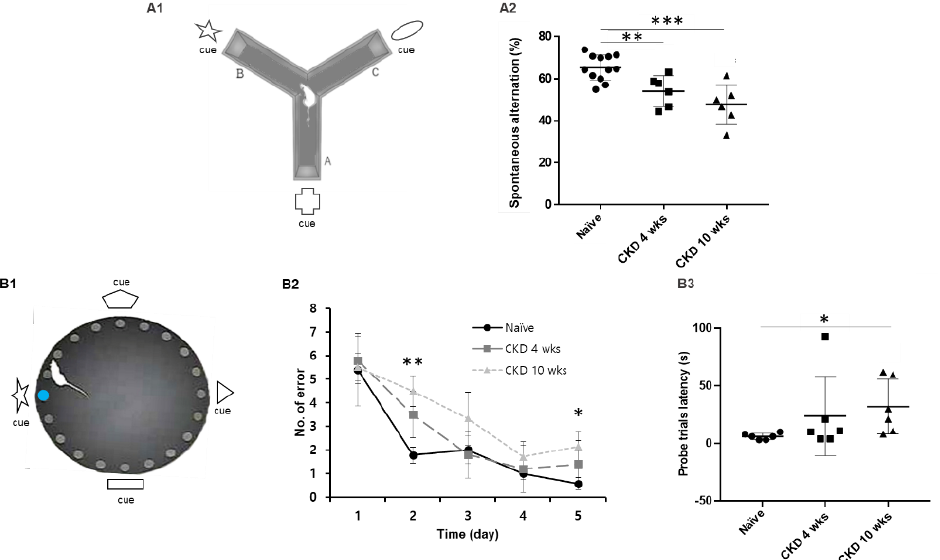
Figure 2. Decreased spatial working memory in CKD model rats. A schematic diagram showing the special cues working memory test ( A1 ). In the CKD rats, the average percentage of spontaneous movement was decreased compared with naïve rats ( A2 ). Barnes maze apparatus was used to ex- amine spatial learning and memory in CKD model rats ( B1 ). The number of errors for escape hole was reduced for all rats upon repeated trials ( B2 ). CKD 10-wk rats had a higher time of error on the second day and fifth day (probe test) compared with naïve rats ( B2 ). The latent time to find the target hole increased on the probe test day in the CKD 10 wks compared with naïve rats. ( B3 ). The blue round symbol in B1indicates the escape hole. Data are presented as means ± SEM. * p < 0.05, ** p < 0.01, *** p < 0.001 by one-way analysis of variance. Y-maze, naïve: n = 12; CKD 4 wks: n = 7; CKD 10 wks: n = 5; Barnes maze: n = 6/group. Additionally, we investigated whether CKD could cause learning and memory dis- orders in contextual fear conditioning (Figure 3). In freezing contextual fear learning, CKD 10-wk rats showed decreased freezing times (6 min, F 1,10 = 6.04, p < 0.05, 7 min, F 1,10 = 7.59, p < 0.05; one-way ANOVA; Figure 3A). After 24 h, contextual fear memory deficits were observed in the CKD rats compared with the naïve rats (CKD 4 wks, F 1,10 = 10.87, p < 0.05, CKD 10 wks, F 1,10 = 18.51, p < 0.001; one-way ANOVA; Figure 3B), indicating that CKD led to deficits in hippocampus-dependent memory. Figure 3. Impairment of contextual fear memory in CKD 4, 10- wk rats. Contextual and cued fear conditioning and 24-h retrieval of contextual memory were performed ( A , B ) No differences in clas- sical fear conditioning were observed in CKD 4-wk rats, although CKD 10-wk rats spent a signifi- cantly lower percentage of time freezing compared with naïve rats ( A ). The horizontal line indicates the duration of a tone (28 s), and the vertical arrow indicates the time of foot shocks (2 s). Deficits in contextual fear memory were observed in the CKD rats ( B ). Data are presented as means ± SEM. * p < 0.05, ** p < 0.01 by one-way analysis of variance, contextual fear conditioning: n = 6/group. 3.2. Decreased fEPSP in the Hippocampal Neurons of CKD Rat Model